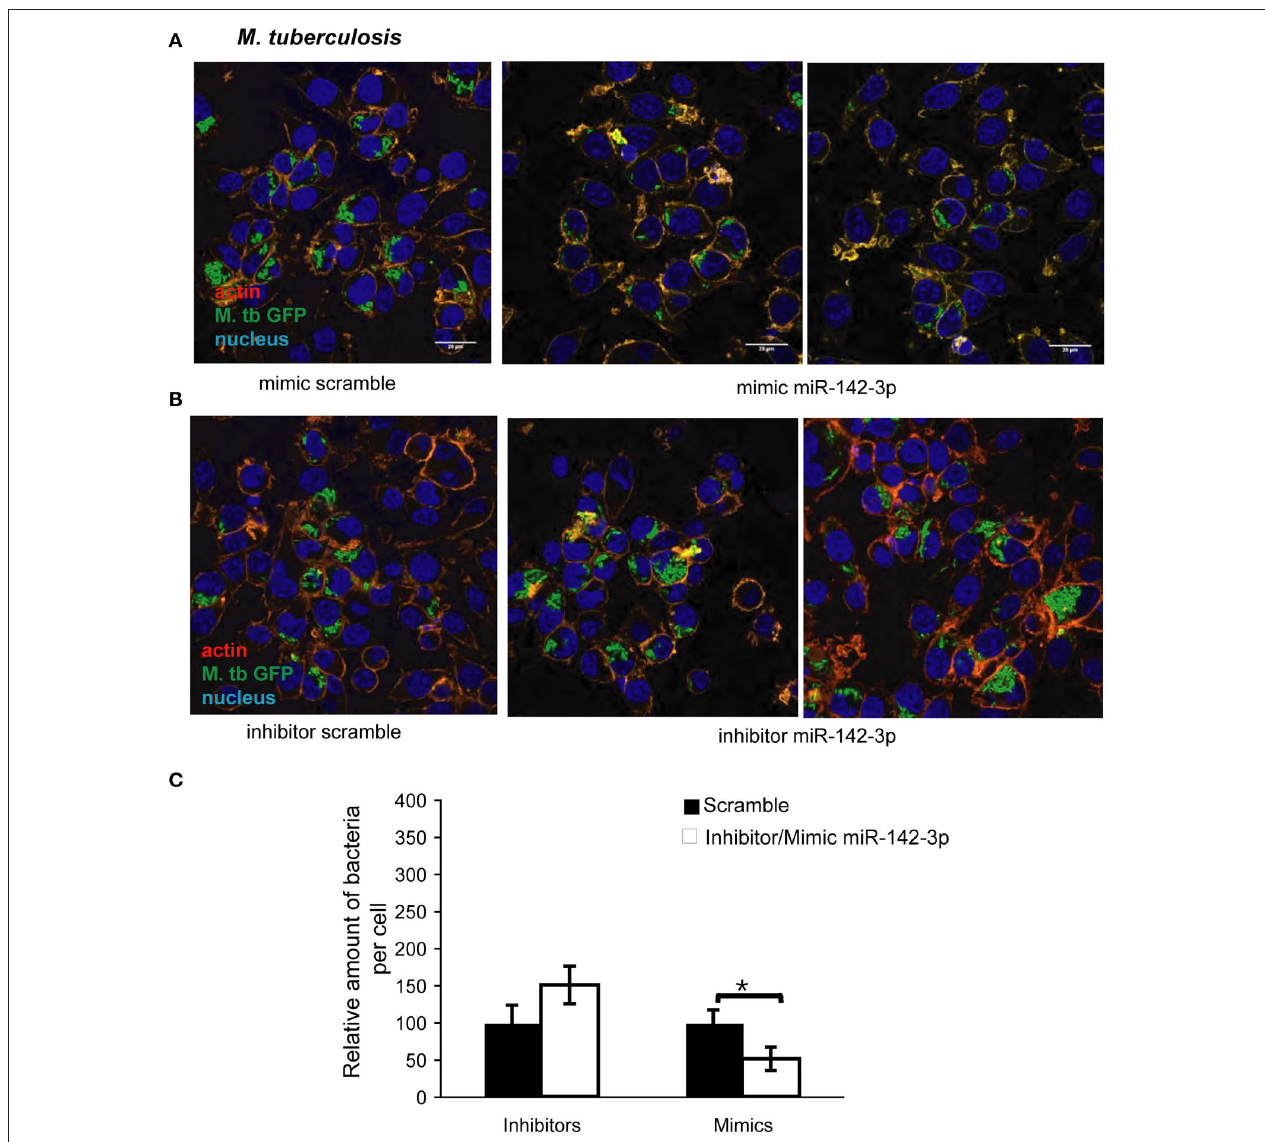
FIGURE 4 | miR-142-3p activity correlates with a reduction of the amount of internalized M. tuberculosis per M ϕ . Confocal microscopy showing quantitative and qualitative analysis of J774A.1 macrophages treated with miR-142-3p mimics (A) or miR-142-3p inhibitors (B) , and challenged with M. tuberculosis (MOI 10) for 4h. Blue (DAPI), green (H37Rv-eGFP), and Light red/orange